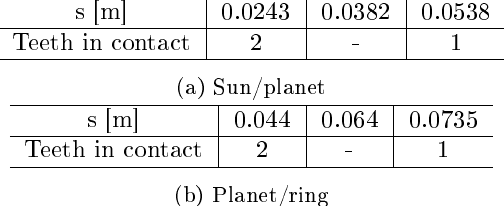
Table 6: Switch between single and multiple teeth in mesh (the planet/ring delimiters are also shown in Figure 12, making it easier to see whether one or two teeth are in mesh).